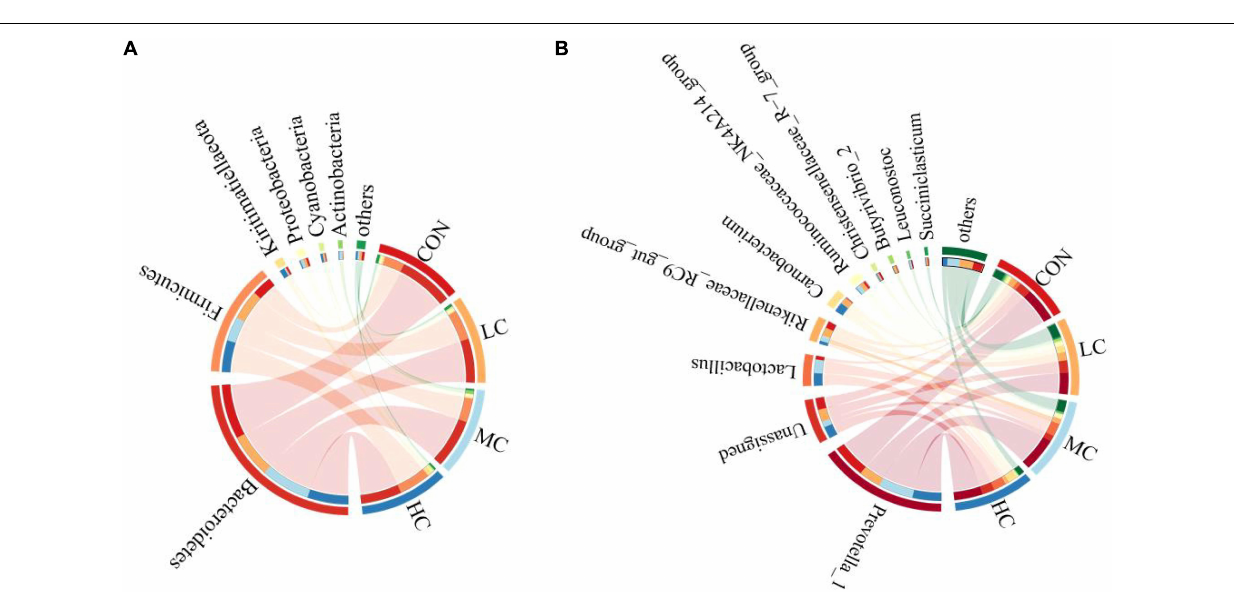
Isobutyrate acid, isovalerate acid, and valerate acid in the rumen fluid, while Spearman correlation and cluster analysis showed positive effect of Carnobacterium on the ratio of Isobutyrate